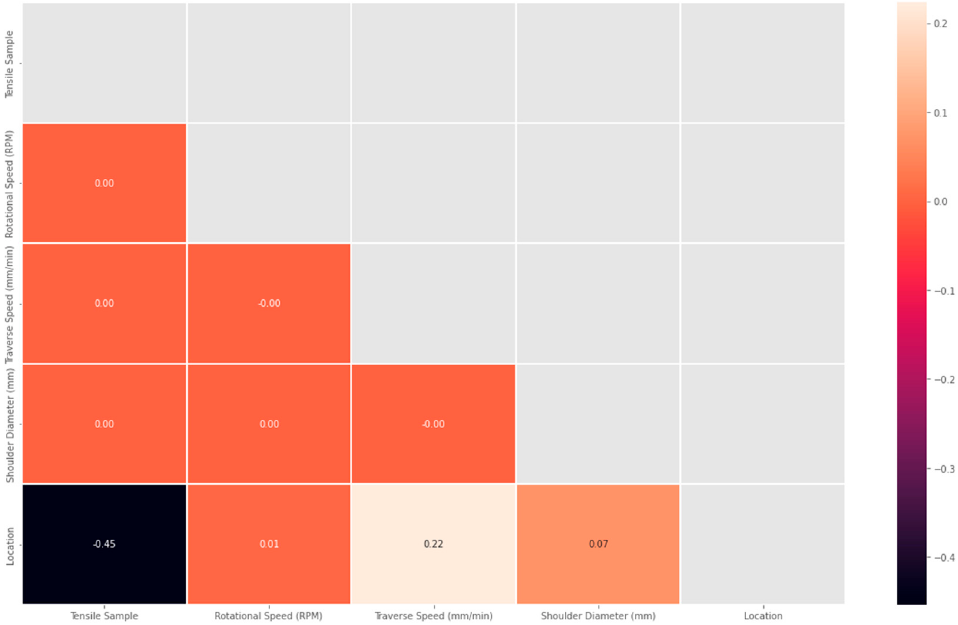
Figure 4. Representation of heat map.